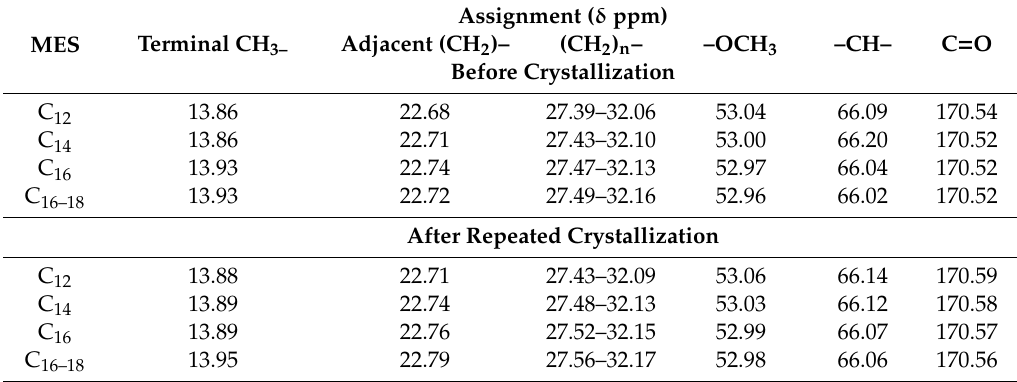
Table 3. Nuclear magnetic resonance analysis (NMR) spectra data of MES before and after repeated